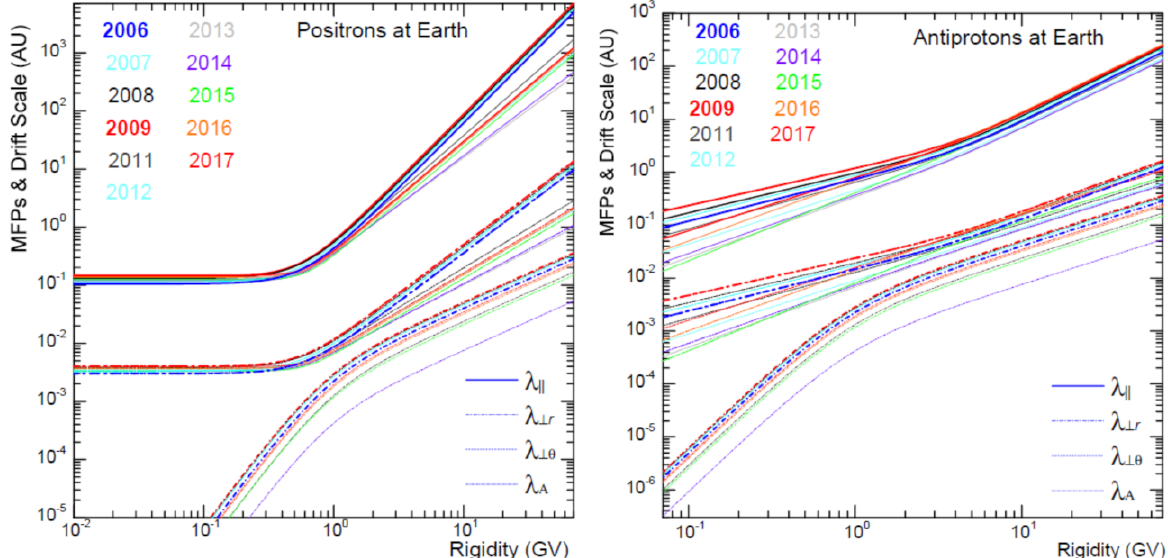
Figure 2. The particles’ mean free paths (MFPs) λ (cid:107) λ ⊥ r , λ ⊥ θ and drift scale λ D ( ≡ λ A ) as a function of rigidity at Earth, for positrons ( left panel) and anti-protons ( right panel), averaged yearly from 2006 to 2017; solid lines indicate the parallel MFPs, dashed-dotted lines indicate the perpendicular MFPs (middle set of curves) and the drift scale (lower set of curves), with different colours for each year as indicated; values of λ ⊥ r and λ ⊥ θ are the same at